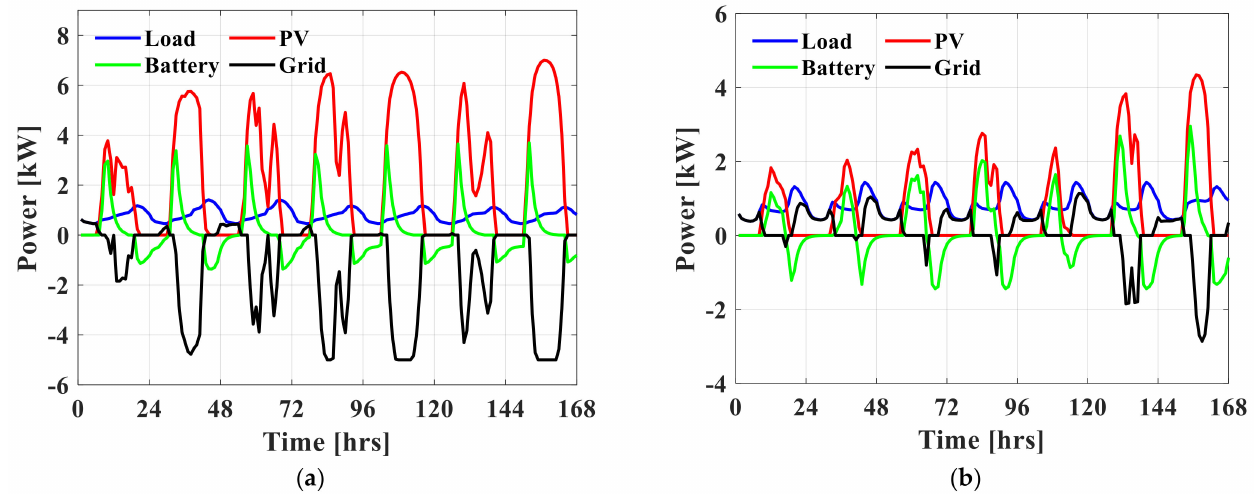
Figure 10. Weekly power flow of the household under Flat-ToU rates: ( a ) Summer week, and ( b ) Winter week.